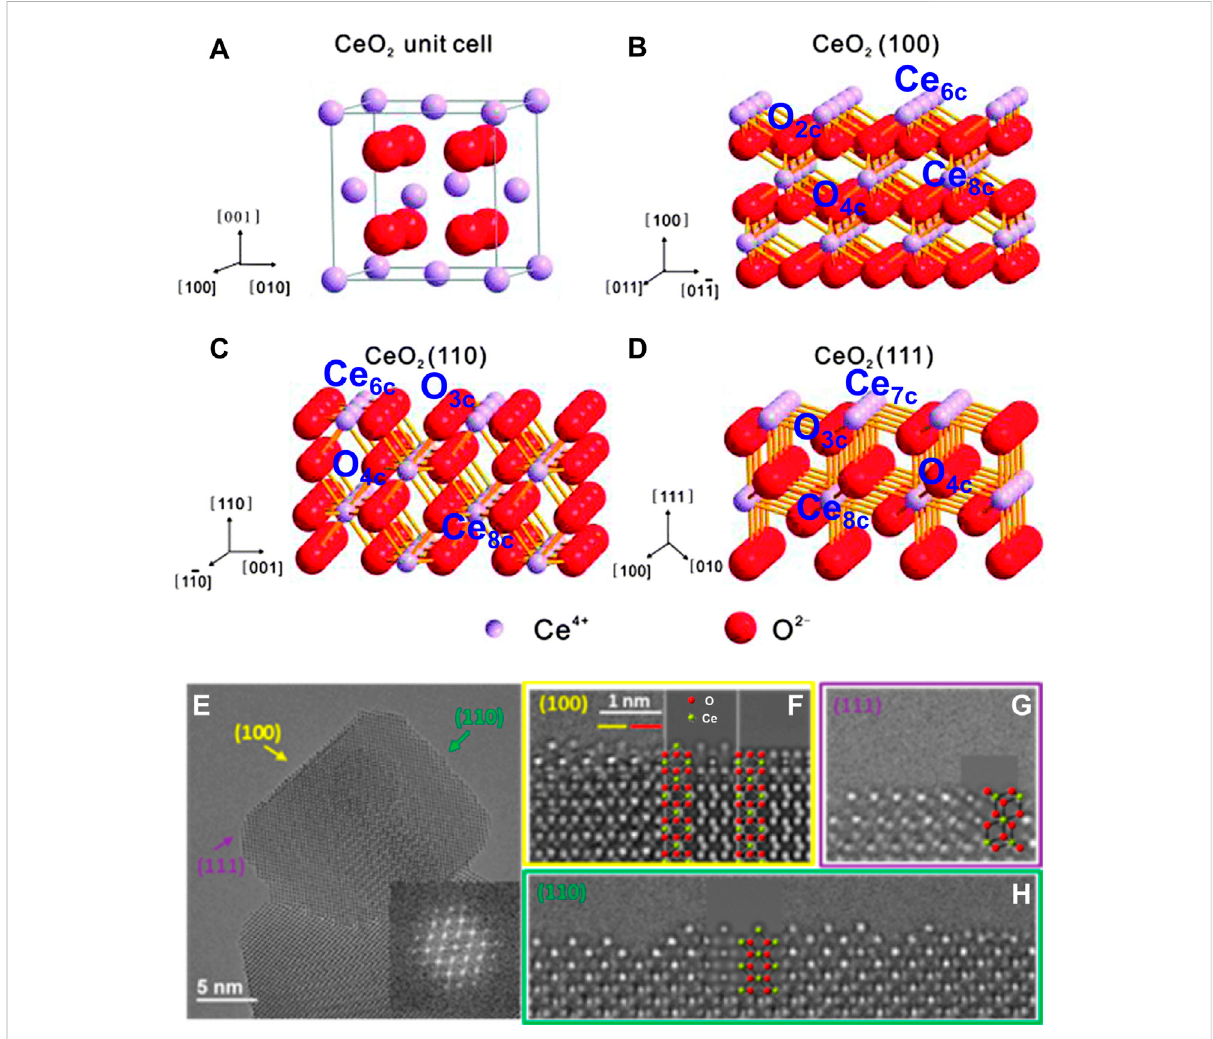
FIGURE 2 Atomic con fi gurations and crystal facets of CeO 2 : (A – D) illustrations of the unit cell (A) and the (100), (110), and (111) facets with marked coordination number of cerium and oxygen atoms (B – D) . Reproduced with permission (Li and Shen, 2014). Copyright 2014, Royal Society of Chemistry. (E – H) The high-resolution electron microscopy (HREM) images and corresponding simulated HREM images of the three surfaces of a typical